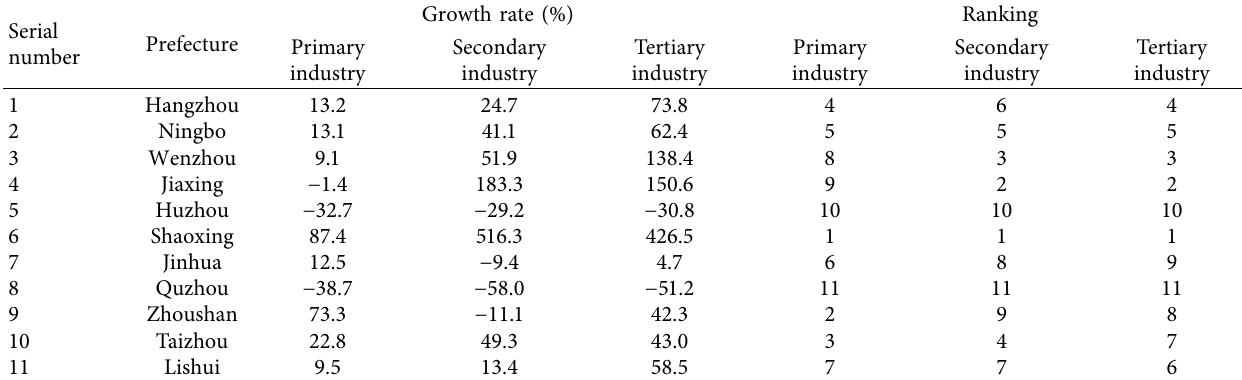
Table 9: Growth rates of the three industries in each prefecture and their